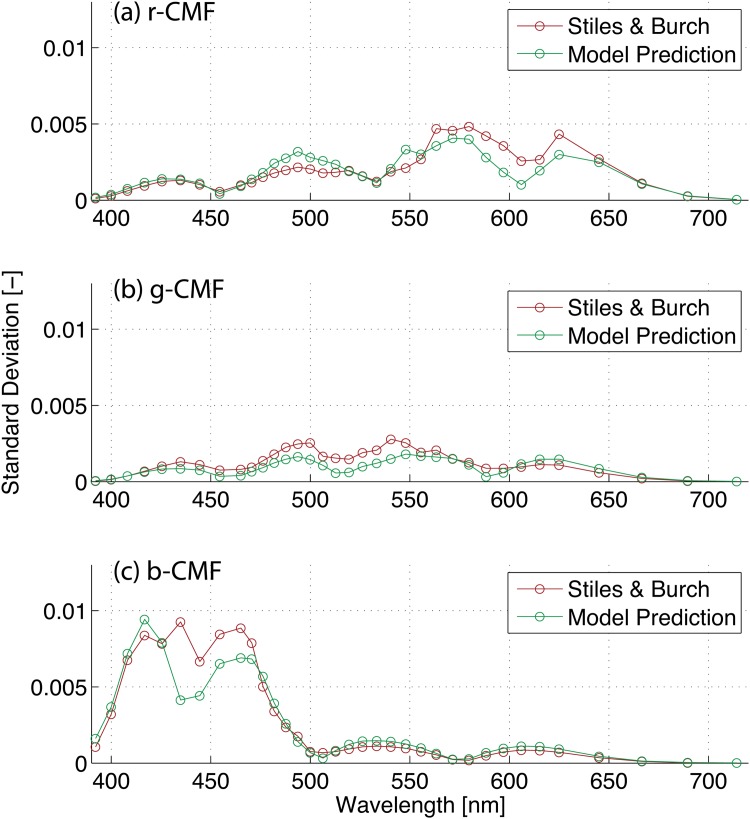
Standard deviations computed for Stiles and Burch’s 49 observers (red lines) and for 49 sets of rgb-CMFs generated by the proposed observer model (green lines).The plot (a), (b), and (c) show standard deviations in red, green, and blue CMFs, respectively. Area-normalized rgb-CMFs are used to compute standard deviations in these plots.